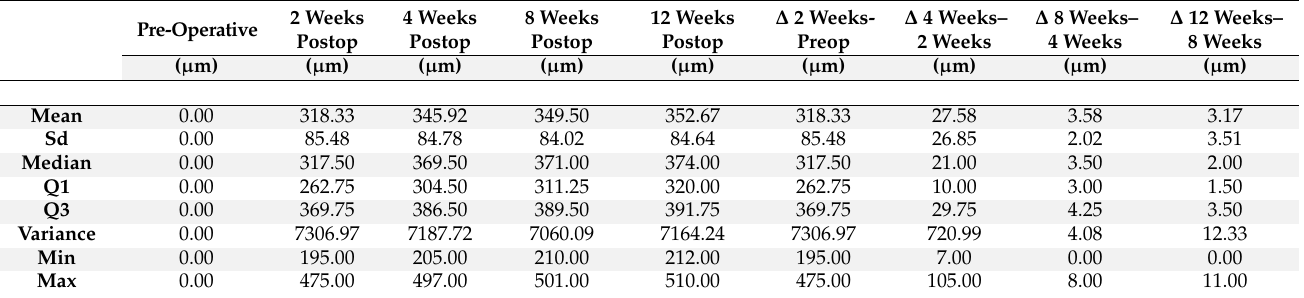
Table 1. Pre-operative and post-operative corneal pachymetry calculated at the thinnest point of the ulcer with anterior segment optical coherence tomography (AS-OCT).